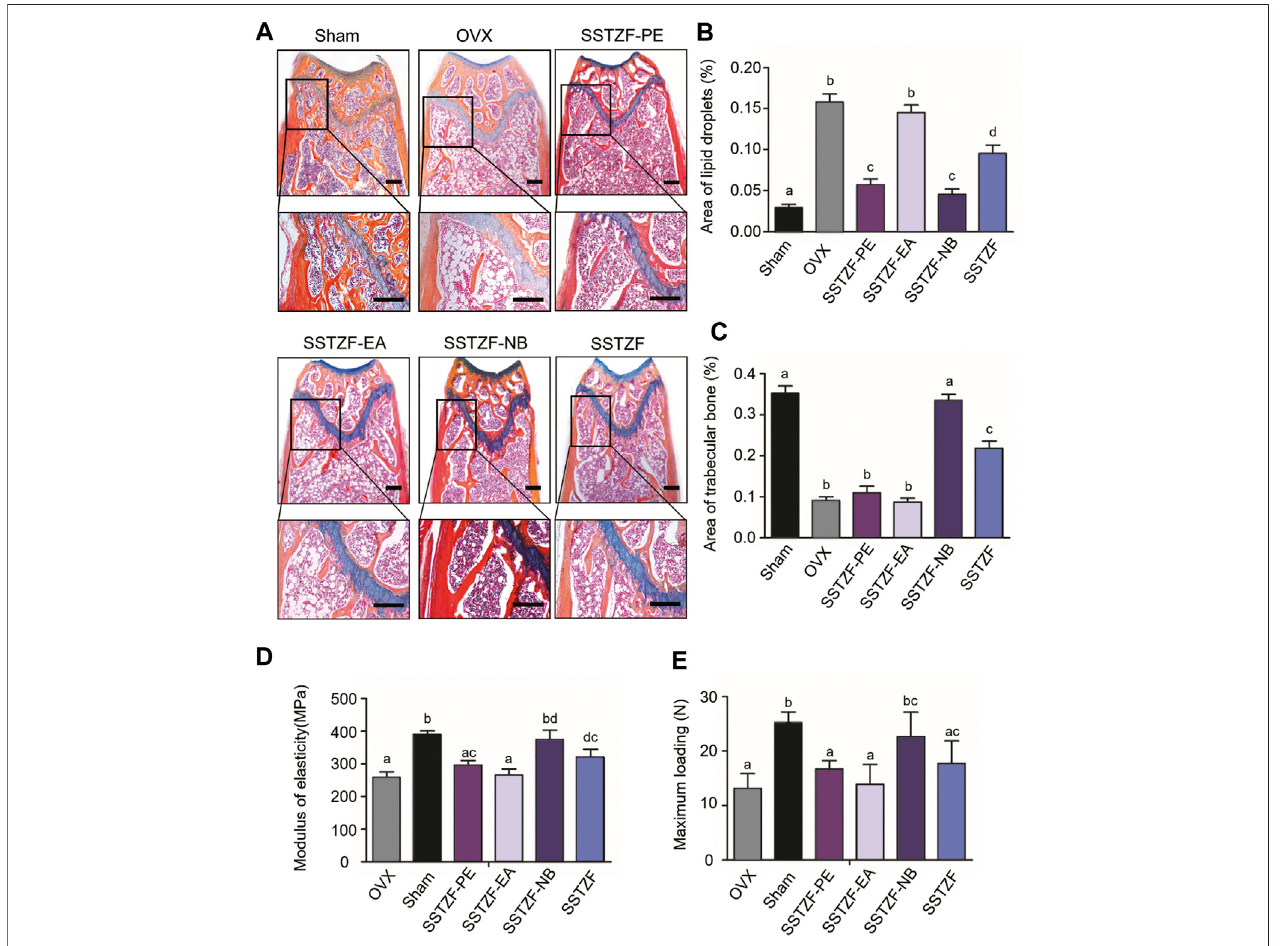
FIGURE 2 | SSTZF-NB increases trabecular bone formation and decreases fat accumulation in the area of the chondro-osseous junction. (A) Alcian Blue Hematoxylin/Orange G staining of the distal femur. (B) The area oflipid droplets. (C) The area of trabecular bone. SSTZF-NB enhances bone strength. (D) The modulus ofelasticity. (E) Themax-loading.Scalebars:1000 μ m A – D :Themeansnotsharingacommonletteraresigni fi cantlydifferentamongthegroupsat p < 0.05byone-way ANOVA with Duncan ’ s multiple-range